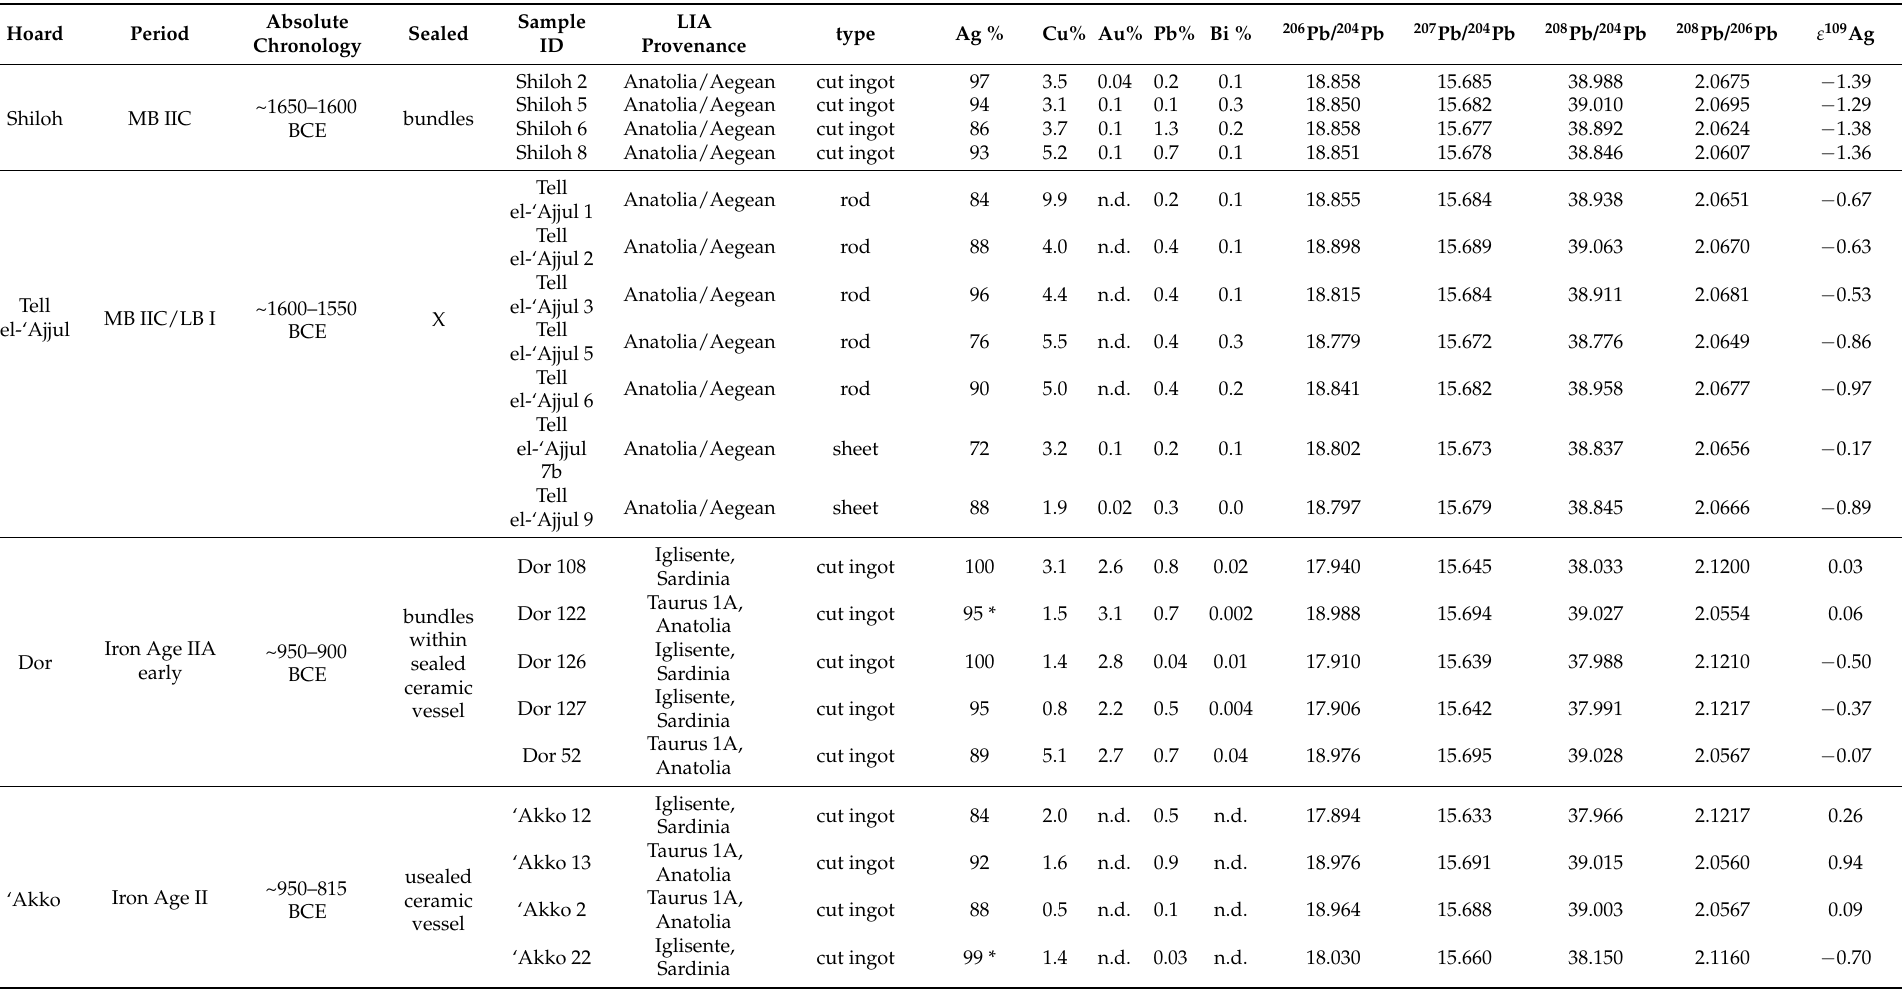
Table 1. The items sampled in this study, including their origin; chronology; type of hoarding (sealed/unsealed), bulk chemistry and LIA-based provenance of silver sampled in this study [6,26,31,33]; and ε 109 Ag values. The hoards from Dor, ‘Akko, ‘Ein hofez and ‘Arad are attributed to the Phoenicians [6,31].